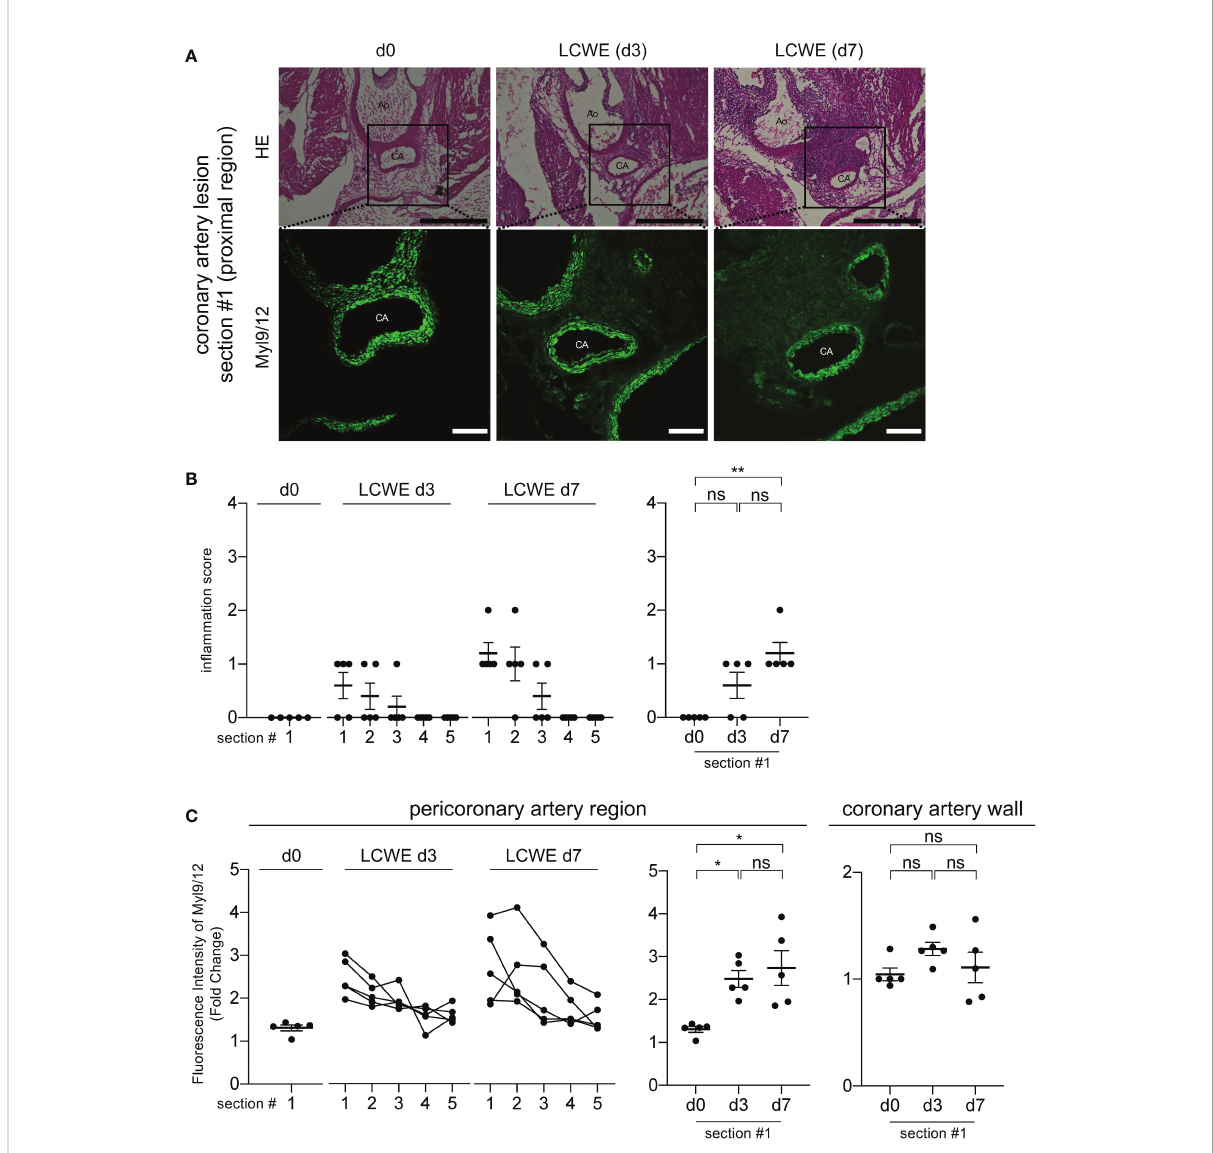
FIGURE 4 Myl9/12 is detected in coronary arteries of LCWE-injected mice prior to the in fi ltration of in fl ammatory cells. (A) HE staining (upper) and IHC staining using anti-Myl9/12 Ab (lower) of the proximal side (section #1 indicated in Figure 3B) of the coronary artery in a control mouse (left) and an LCWE-injected mouse at 3 days (middle) and 7 days (right) after the administration of LCWE. Scale bars indicate 500 m m (low-power fi eld) and 100 m m (high-power fi eld). CA, coronary artery; Ao, aorta. (B) In fl ammation scores of fi ve consecutive sections of the coronary arteries of LCWE-injected mice on day 0 (d0, n=5), day 3 (LCWE d3, n=5), and day 7 (LCWE d7, n=5) after the administration of LCWE. Section #1 is the most proximal side, and section #5 is the most distal side of the origin of the coronary artery (left). The in fl ammation scores using section#1 compared among d0, d3 and d7 was shown (right). ** P < 0.01 (multiple comparisons, one-way ANOVA), ns; not signi fi cant. Data are shown as the mean ± SEM. (C) The fl uorescence intensity of Myl9/12 in the pericoronary artery region (left and middle) and in the coronary artery wall (right) among control mice (d0, n=5), and LCWE-injected mice on day 3 (LCWE d3, n=5) and day 7 (LCWE d7, n=5) after the administration of LCWE. Section #1 is the most proximal side and #5 is the most distal side (left). The fl uorescence intensity of Myl9/12 in the peri-coronary artery (middle) and in the coronary artery wall (right) using the section #1 compared among d0, d3 and d7 was shown. Data were normalized to controls. * P < 0.05 (multiple comparisons, one-way ANOVA). ns, not signi fi cant. Data are shown as the mean ±